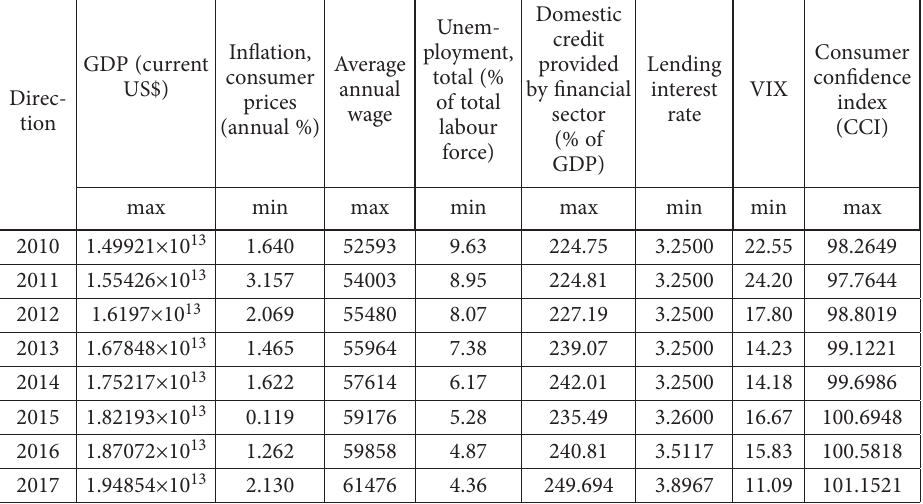
Table 6. US macroeconomic data, 2010–2017 (source: Federal Reserve Bank of St. Louis, 2020; OECD, 2019; World Bank, 2019a, 2019b, 2019c, 2019d, 2019e)